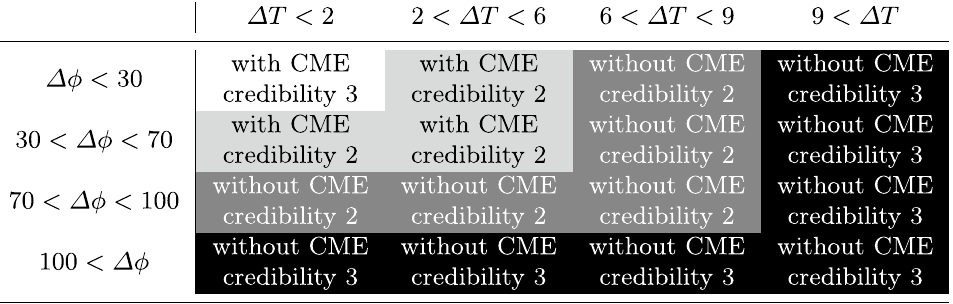
The units of ∆ T and ∆φ are hour and deg,